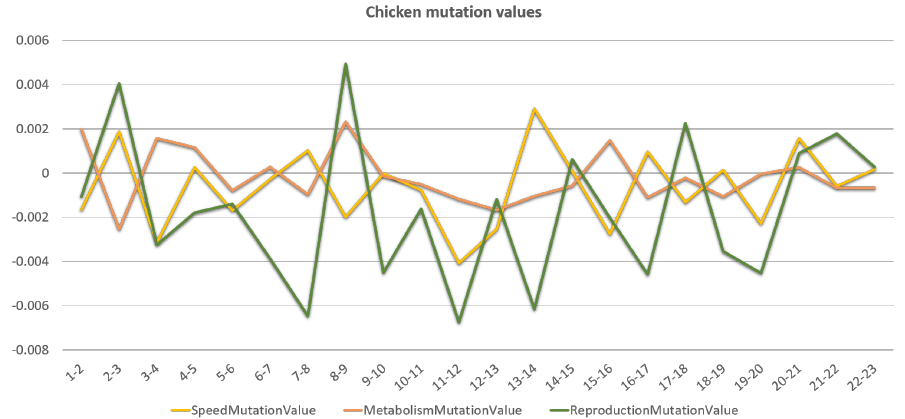
Figure 23. The diagram shows the average mutation values during 23 Chicken generations. Because the mutation values are randomly generated within the specified range, they are evenly dispersed as positive and negative mutation effects for every individual, but every generation has a different ratio of mutations.